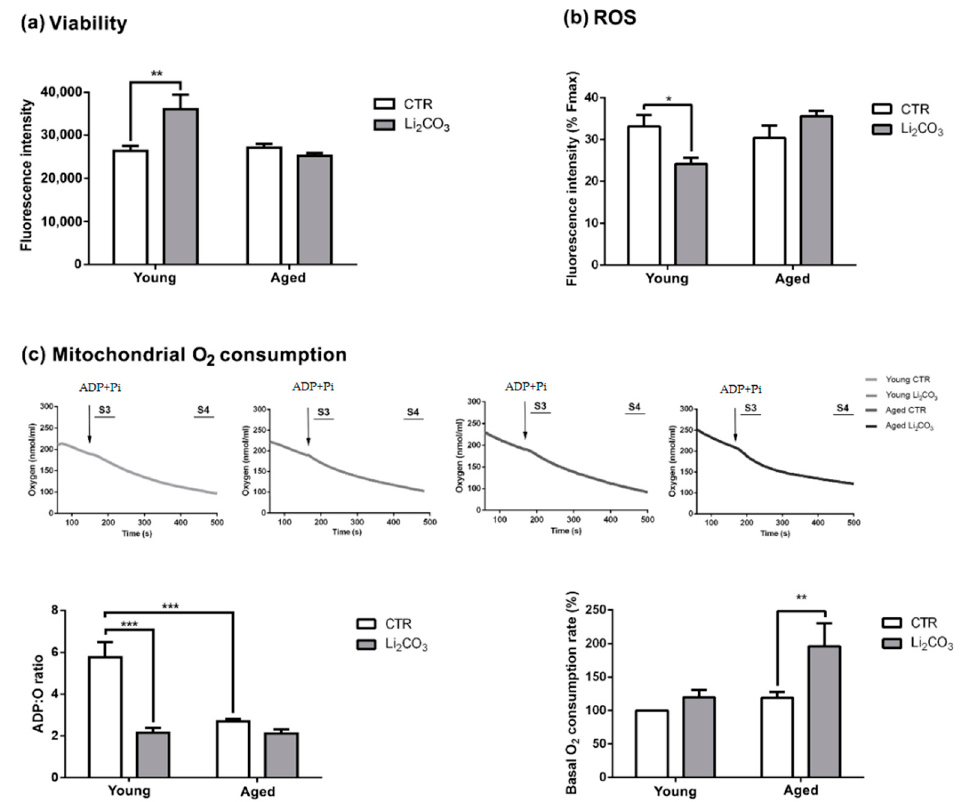
Figure 2. Cytoprotective effect of lithium in young but not aged striatal slices. Histograms of the mean maximum fluores- cence of ( a ) calcein in the striatum of young and aged rats, ( b ) 5-(and-6-)-chloromethyl-2 (cid:48) ,7 (cid:48) -dichlorodihydrofluorescein diacetate, acetyl ester (CM-H 2 DFCDA) after stimulus with glutamate (1mM) and normalized by tert-butyl hydroperoxide (TBHP) (30 mM); ( c ) Histogram of the adenosine diphosphate (ADP):O ratio (state 3/4) after the addition of adenosine diphosphate (ADP, 5 µ M) and inorganic phosphate (Na 2 HPO 4 , 5 µ M) and basal oxygen consumption rate analyzed by state 4 measures. The values are presented as a ratio or percentage of consumption oxygen rate ( b , c ). All histograms are a mean ± SEM ( n = 4). * p < 0.05, ** p < 0.01 and *** p < 0.001 compared to control (two-way ANOVA, Bonferroni